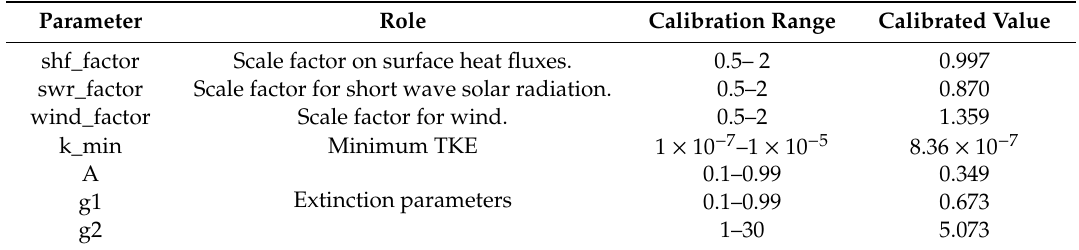
Table 2. List of the general oceanographic turbulence model (GOTM) parameters calibrated as part of the calibration process. Parameter Role Calibration Range Calibrated